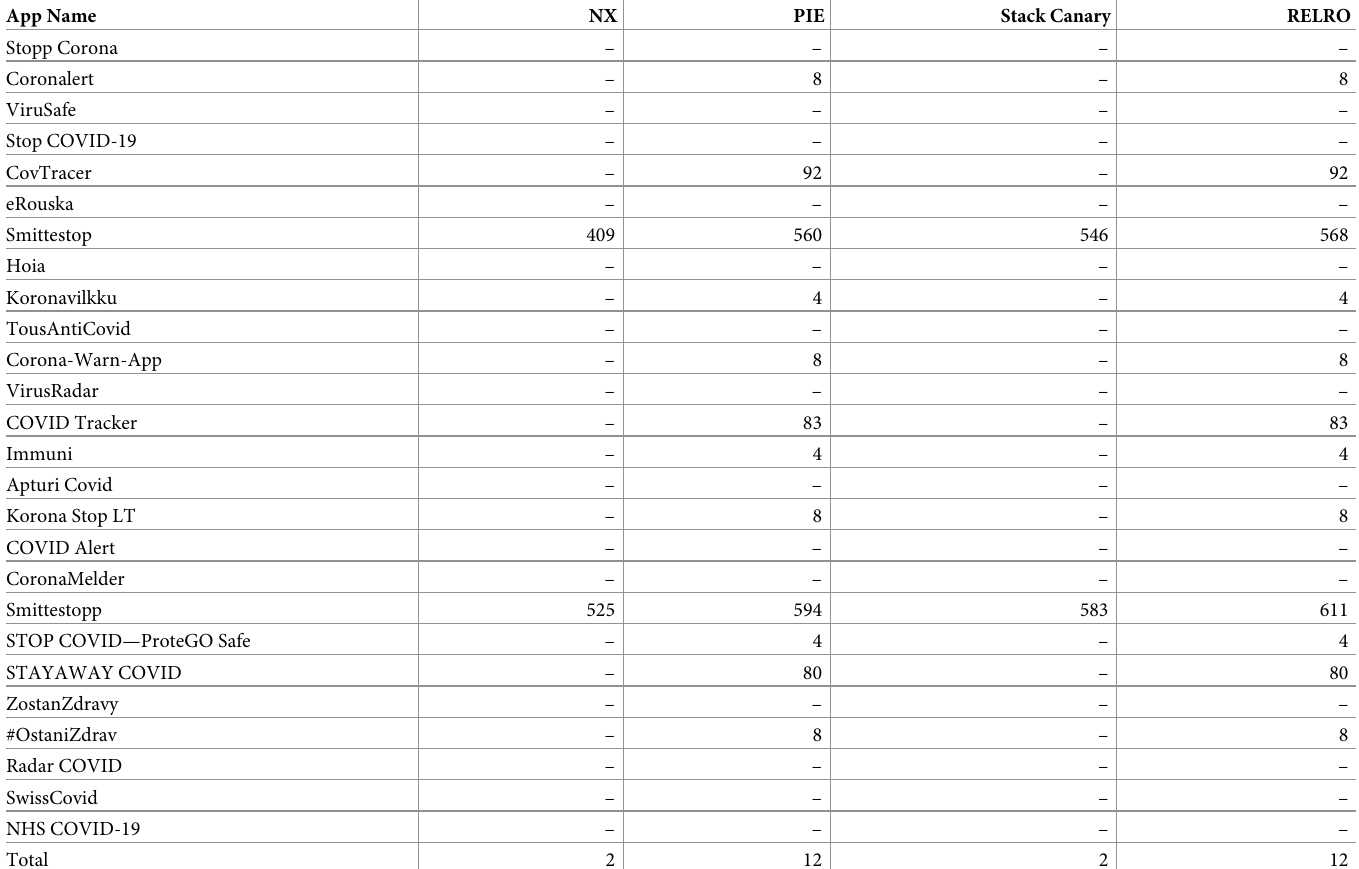
Table 8. Shared library issues per